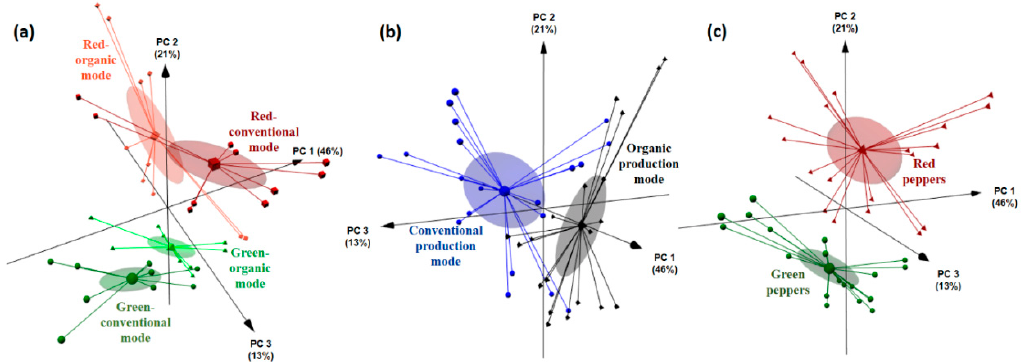
Figure 3. Unsupervised differentiation (3D principal component analysis (PCA) plots) of Entinas sweet peppers based on the nine individual phenolics detected by HPLC-DAD (caffeic, chlorogenic, m-coumaric and o-coumaric acids, luteolin-7- O -glucoside, myricetin, resveratrol, rutin and quercetin-3- O -rhamnoside, µg g − 1 dw), total phenolic content (TPC, µg g − 1 dw) and radical scavenging activity data (DPPH, in %; ABTS •+ , in %; and, TEAC, in mg Trolox g − 1 ): ( a ) according to the agronomic production system (organic and conventional) and the maturation stage (green and red peppers); ( b ) according to the agronomic production system (organic and conventional) independently of the maturation stage; ( c ) according to the maturation stage (green and red peppers) independently of the agronomic production system.